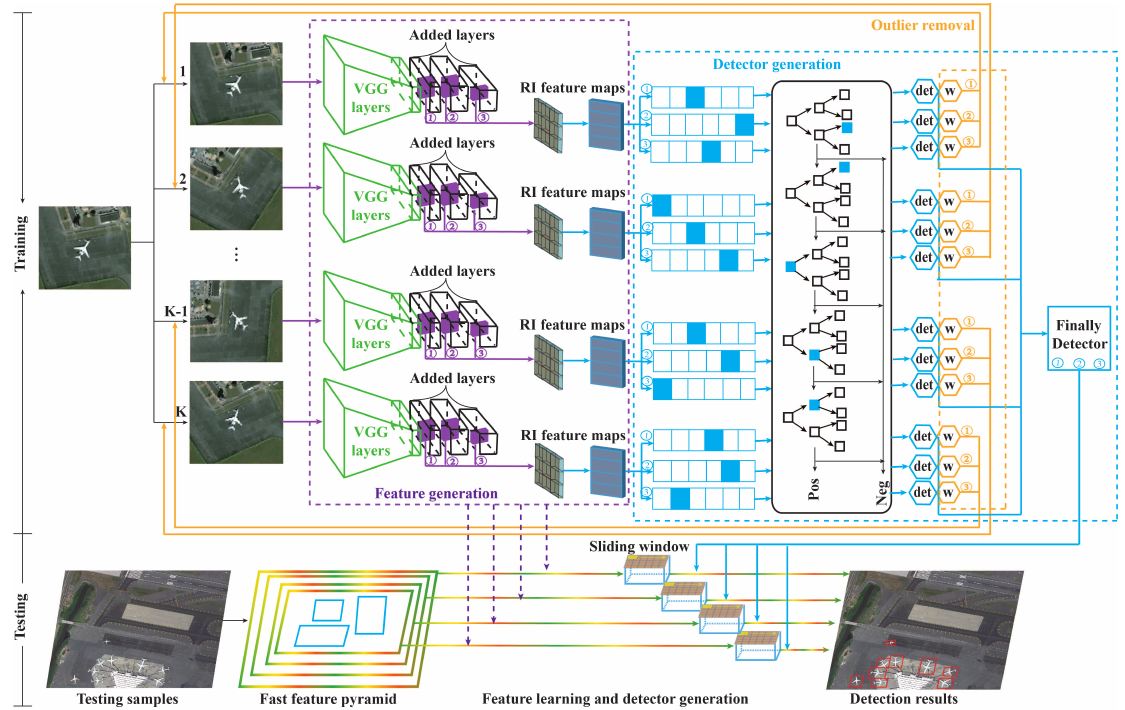
Figure 1. The architecture of the proposed multi-scale and rotation-insensitive convolutional channel features (MsRi-CCF) method. The feature generation step in the training phase is detailed in Figures 2 and 3. These generated features are then fed into the AdaBoost classifier with outlier removal (see Figure 4 for more details) for the final classification and localization. In the test phase, a fast feature pyramid is applied for the final